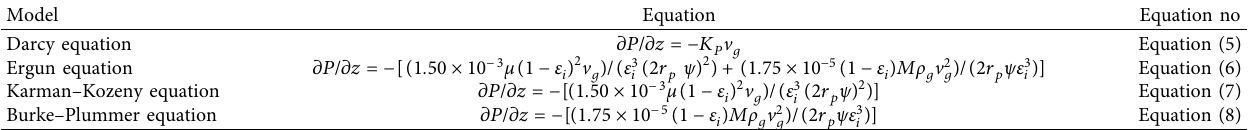
Table 2: Several pressure drop models that are widely adapted for diferent fow conditions [34].